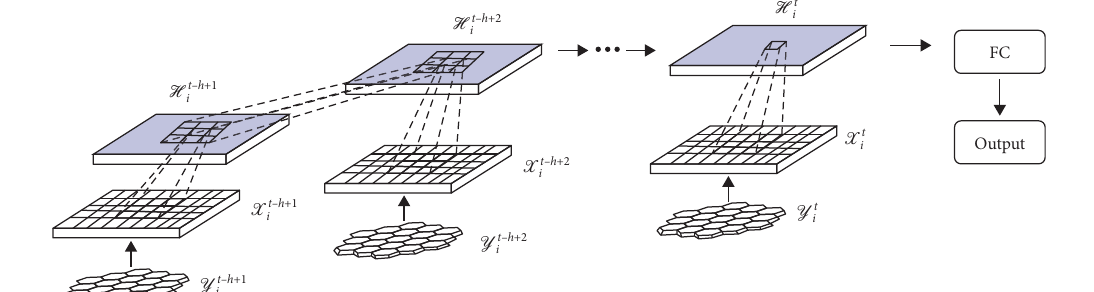
Figure 4: The architecture of H-ConvLSTM.